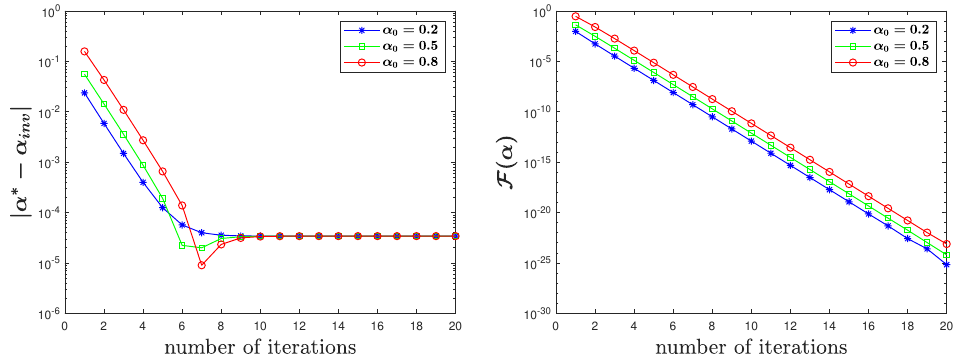
Figure 2. α ∗ = 0.3 for uncontaminated observation data in Test